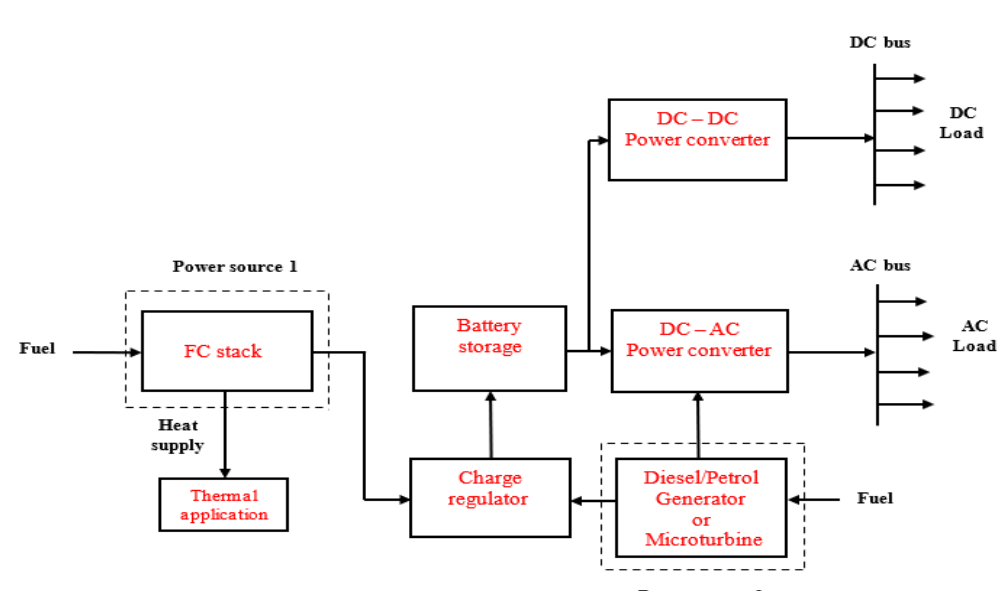
Figure 6. Stand-alone application based on the FC and PV power sources.